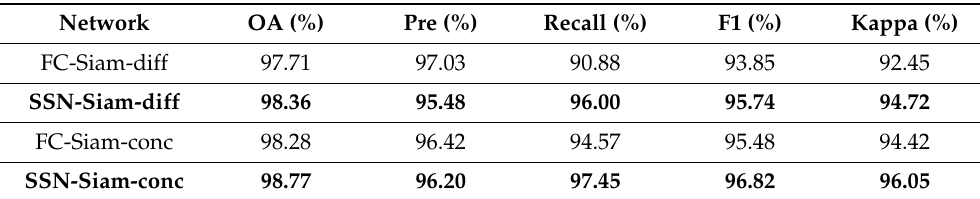
Table 4. Quantitative results of Sulzberger dataset for models with SSN or without.